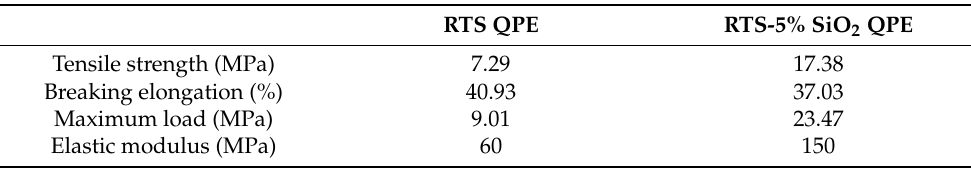
Table 1. Mechanical properties of polymer electrolyte membranes.